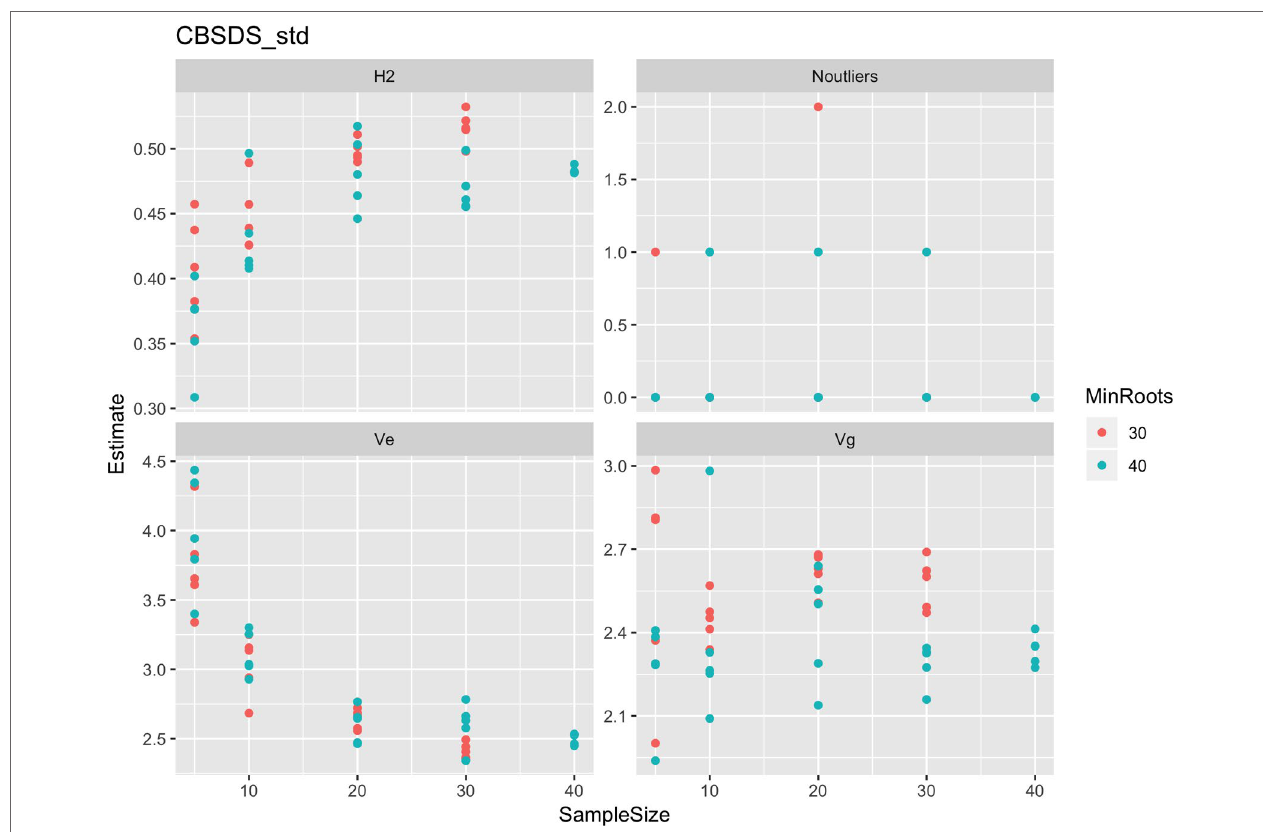
FiGURe 6 | Influence of root sample sizes on standardized root necrosis index (CBSD-standardized). H 2 , broad-sense heritability; Ve, error variance component; Vg, genetic variance component; Noutliers, number of outliers. Analysis based on resampling of 5, 10, 20, 30, or 40 roots from each plot at random.